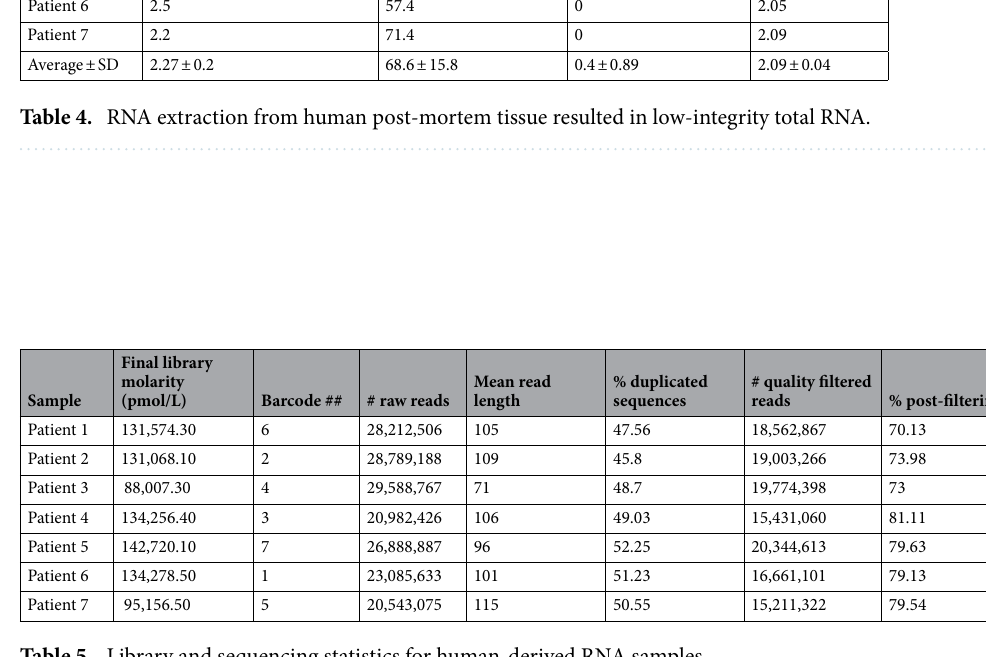
Table 5. Library and sequencing statistics for human-derived RNA samples